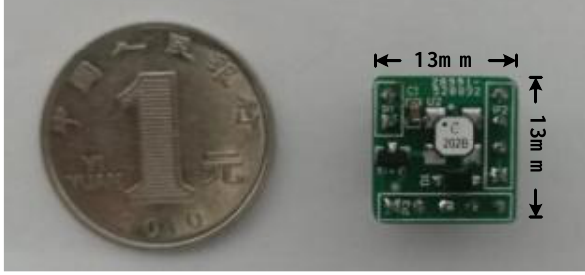
Figure 11. Image of the fabricated converter.